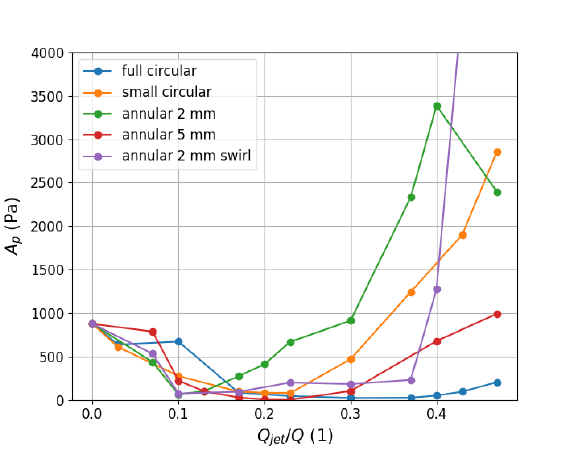
Fig. 13. Amplitudes of the static pressure in position MG1 for different methods of vortex rope mitigation